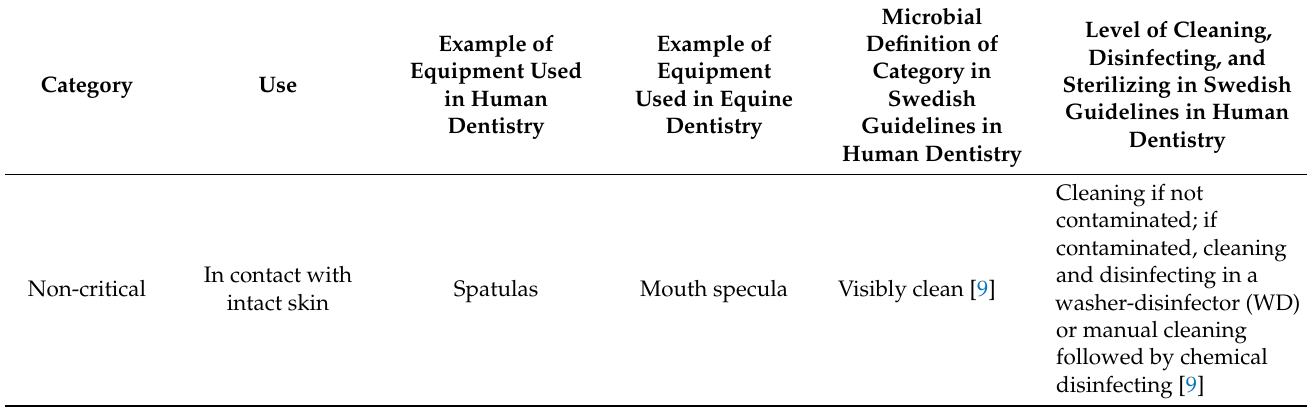
Table 1. Presentation of categorization of dental equipment in human dentistry, area of use, microbial definition accord- ing to Swedish guidelines and standards, and the level of cleaning, disinfecting, and sterilizing needed, according to Swedish